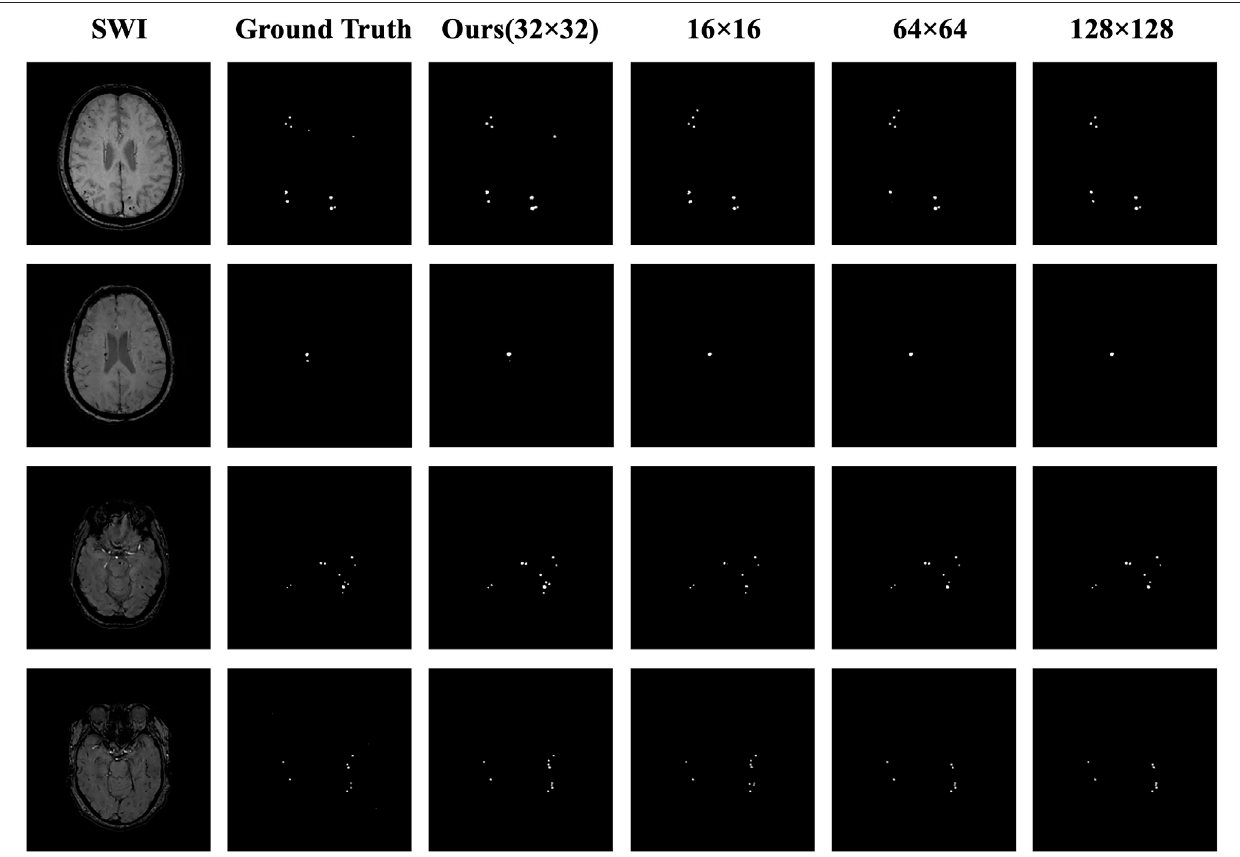
TABLE 4 | Comparison of the effectiveness of the four ablation combinations (%).